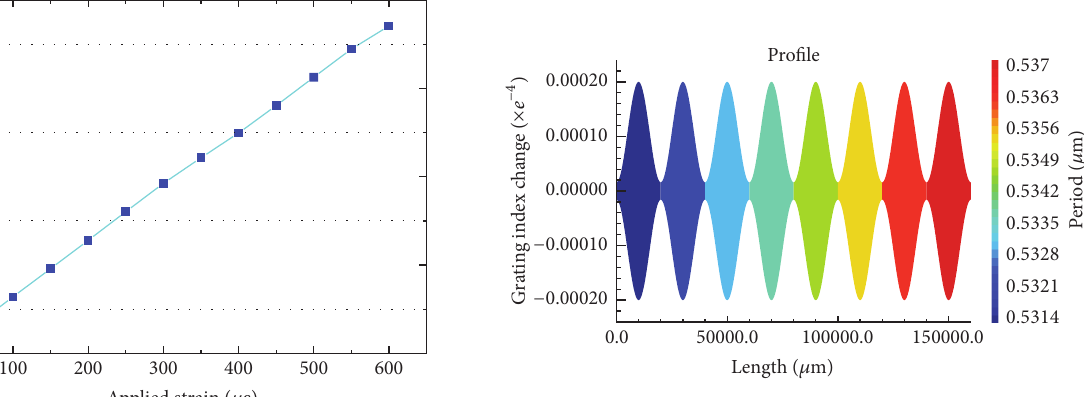
Figure 13: The eight hamming apodized FBG strain sensors refrac- tive index